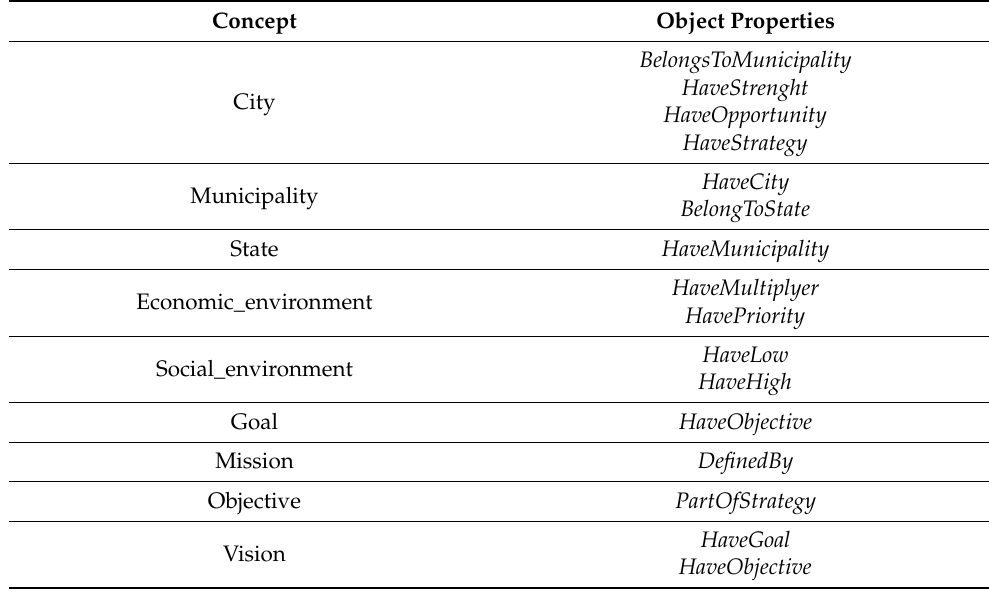
Table 1. Concepts and object properties.